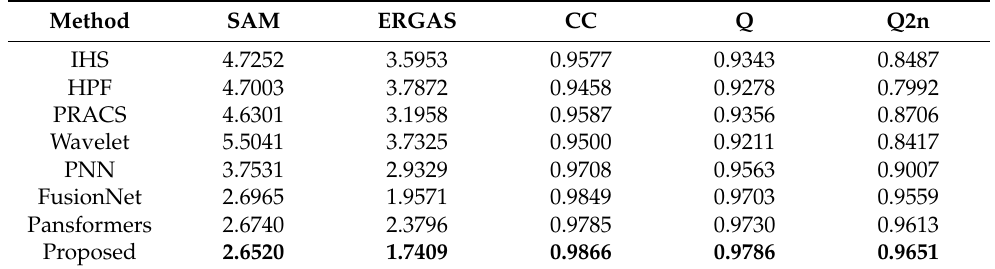
Table 6. Quantitative evaluation of simulation experiment results using the WorldView-2 dataset. Figure 10. Simulation experiment results using the WorldView-2 dataset. ( a ) IHS, ( b ) HPF, ( c ) PRACS, ( d ) Wavelet, ( e ) PNN, ( f ) FusionNet, ( g ) Pansformers, ( h ) LNFIN, ( i ) GT. Method